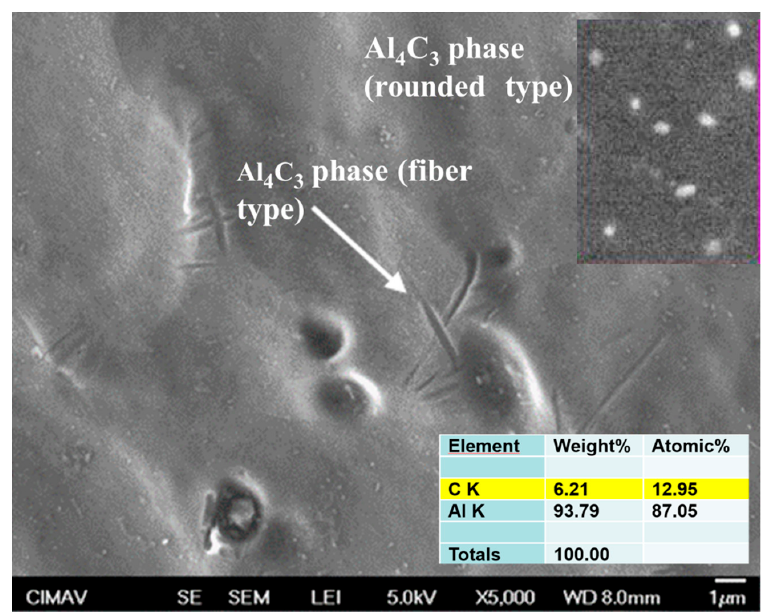
Figure 15. SEM secondary electrons image of the Al/C composite.